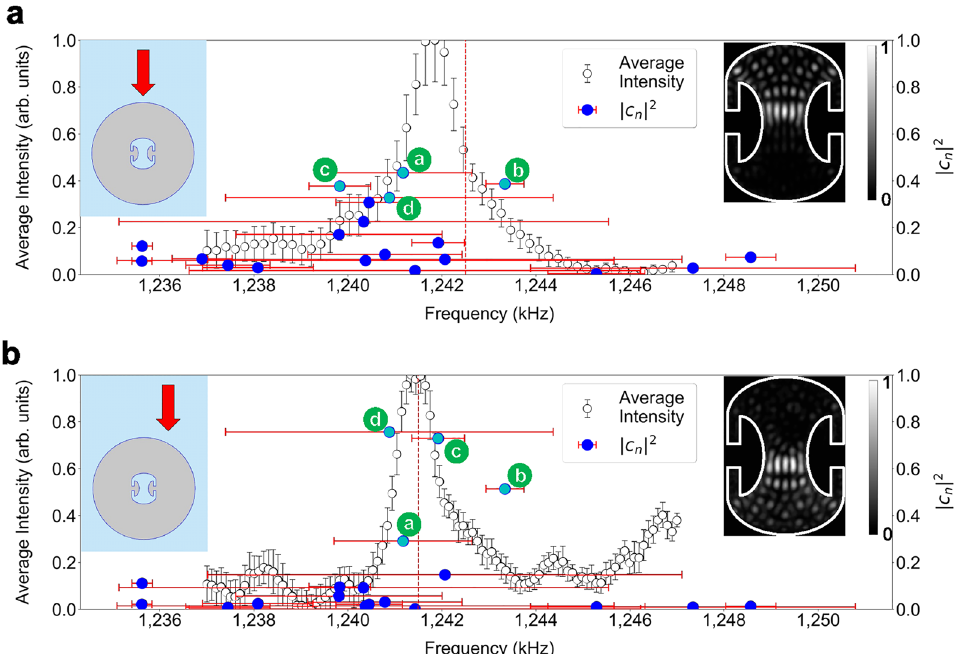
Figure 5. Flipping the half-illuminated region. The normalized spectrum of ( a ) the HIM and ( b ) the inverted HIM. The left and right insets are the excitation position and the steady-state mode pattern, respectively in each case. The peak frequencies are (1241.713 ± 0.033) kHz for ( a ) and (1241.410 ± 0.056) kHz for ( b ), respectively. The HIM (inverted HIM) is excited at 1242.5 kHz (1241.5 kHz). The excitation frequencies are indicated as red dashed lines. The blue dots represent the eigenmodes contributing to the HIM (inverted HIM) with the horizontal positions indicating their resonance frequencies and red horizontal bars showing their linewidths. Their vertical positions of the dots indicate the magnitude of corresponding modes, also shown in Fig. 3b as labelled a, b, c and d, are colored in cyan. The vertical error bar indicates one- standard deviation at each sample